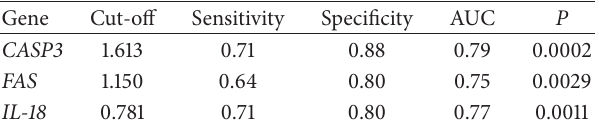
Table 6: ROC analysis results for graft function (GFR > 50 mL/min) 24 months after